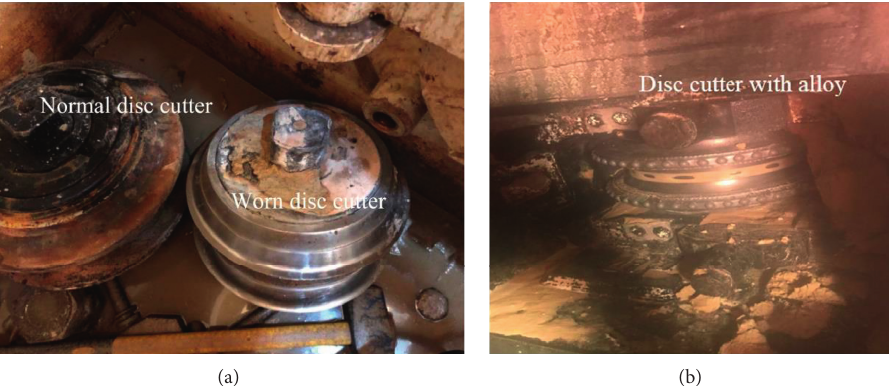
Figure 14: Replacement of worn disc cutters: (a) comparison of normal and worn disc cutter and (b) replacement disc cutter containing an alloy.